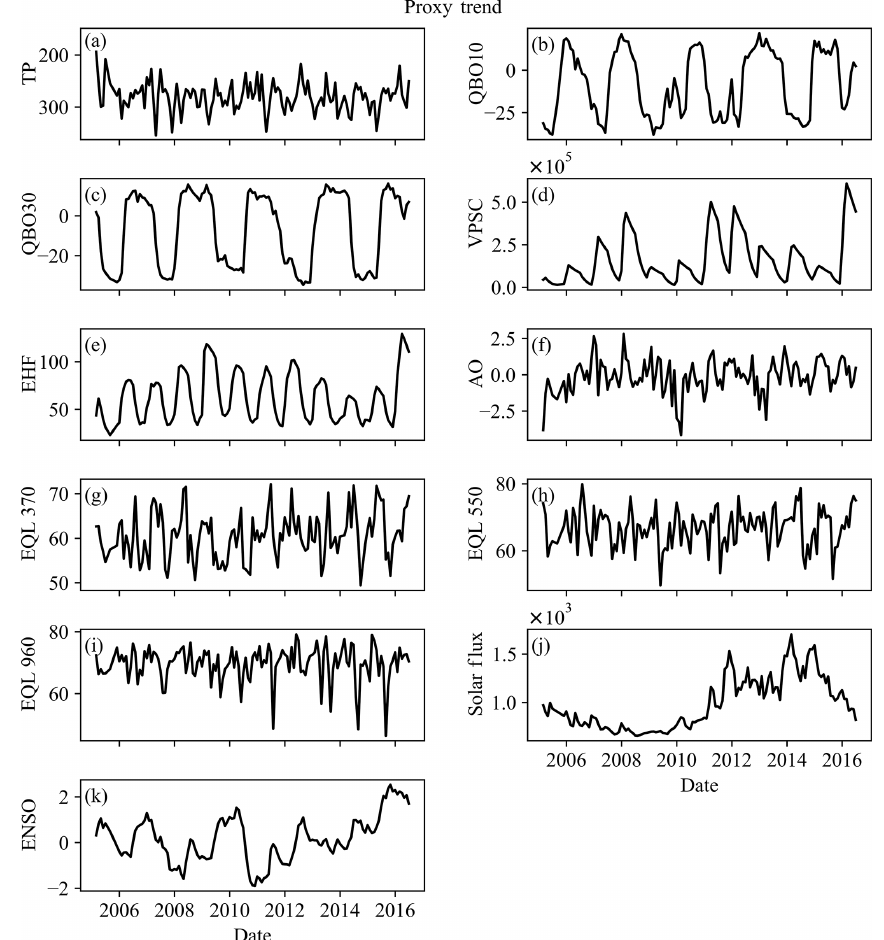
Figure 4. Time series of the proxies used in this study to analyze ozone variations over Summit Station, Greenland. The sources of the proxies are listed in Table 1. The units of the proxies are unitless for ENSO and AO; meters per second for QBO10 and QBO30 (positive values are westerly zonal winds, and negative values are easterlies), watts per square meter for solar flux and eddy heat flux (EHF), hectopascals for tropopause pressure (TP), 10 6 km 3 for volume of polar stratospheric clouds (VPSC), and degrees for equivalent latitude (EQL) at potential temperatures of 370, 550, and 960K. The proxy for VPSC is actually the cumulative volume of polar stratospheric clouds times the effective equivalent stratospheric chlorine (EESC), and cumulative EHF is named EHF (Brunner et al., 2006), as explained in the text. The proxies for TP and EQL are for Summit